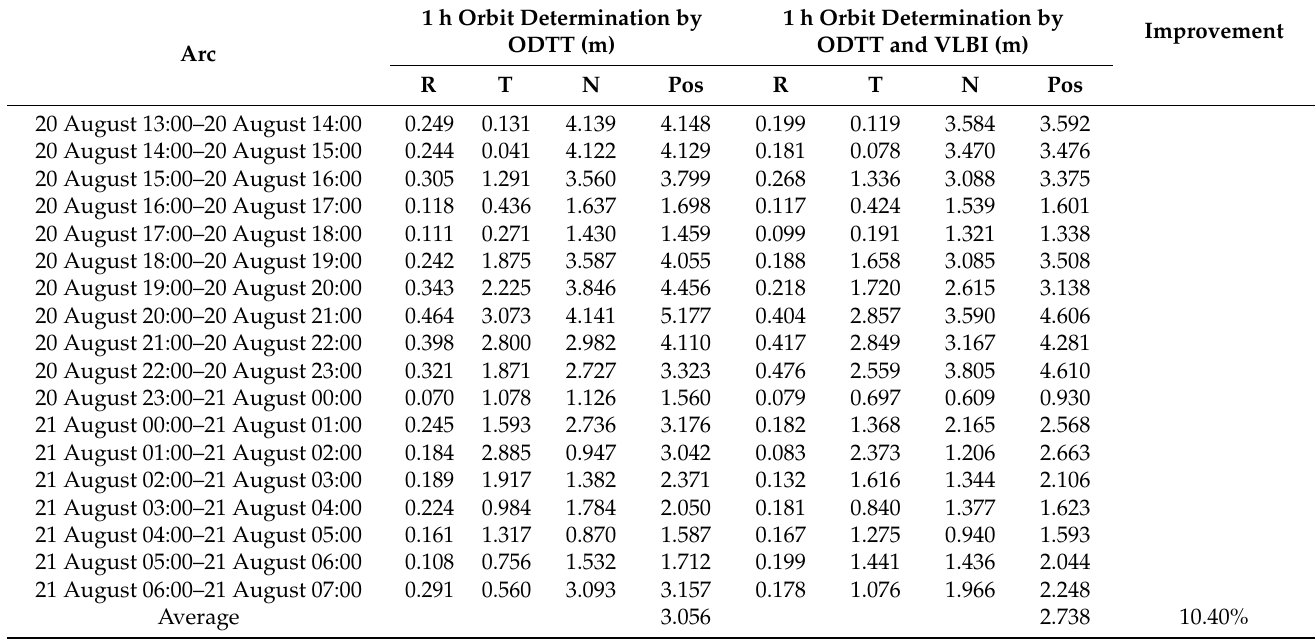
Table 6. The results of bias with arcs of 1 h.